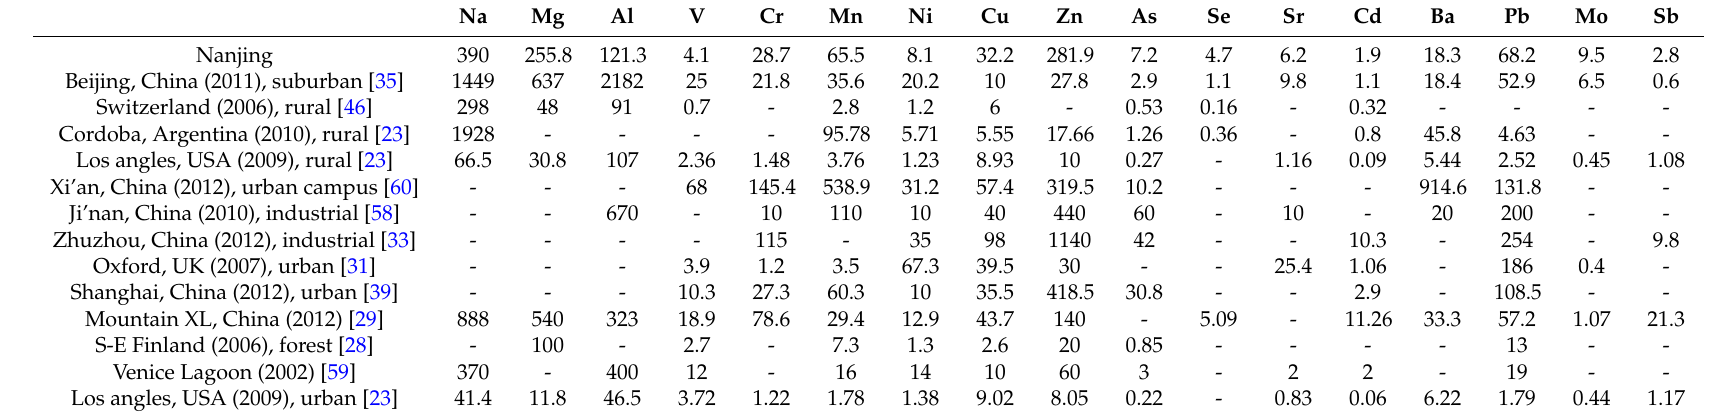
Table 2. Concentrations of metals in Nanjing PM 2.5 and aerosol metal concentrations in a selection of previous studies of China and other countries. Na